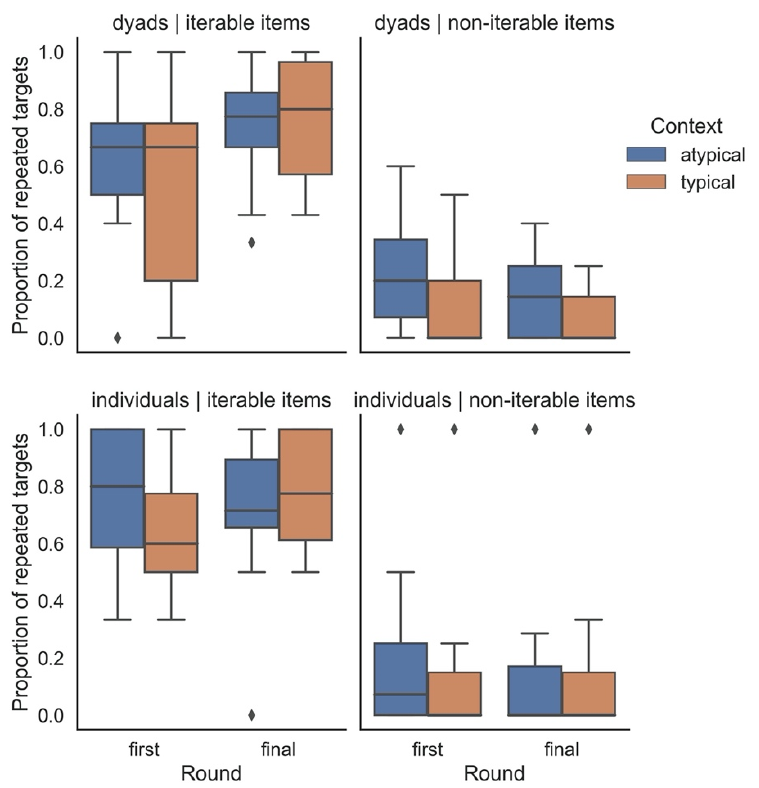
Figure 11. Proportion of repeated targets, shown for iterable and non-iterable target actions, and for participants in the dyadic and individual conditions.